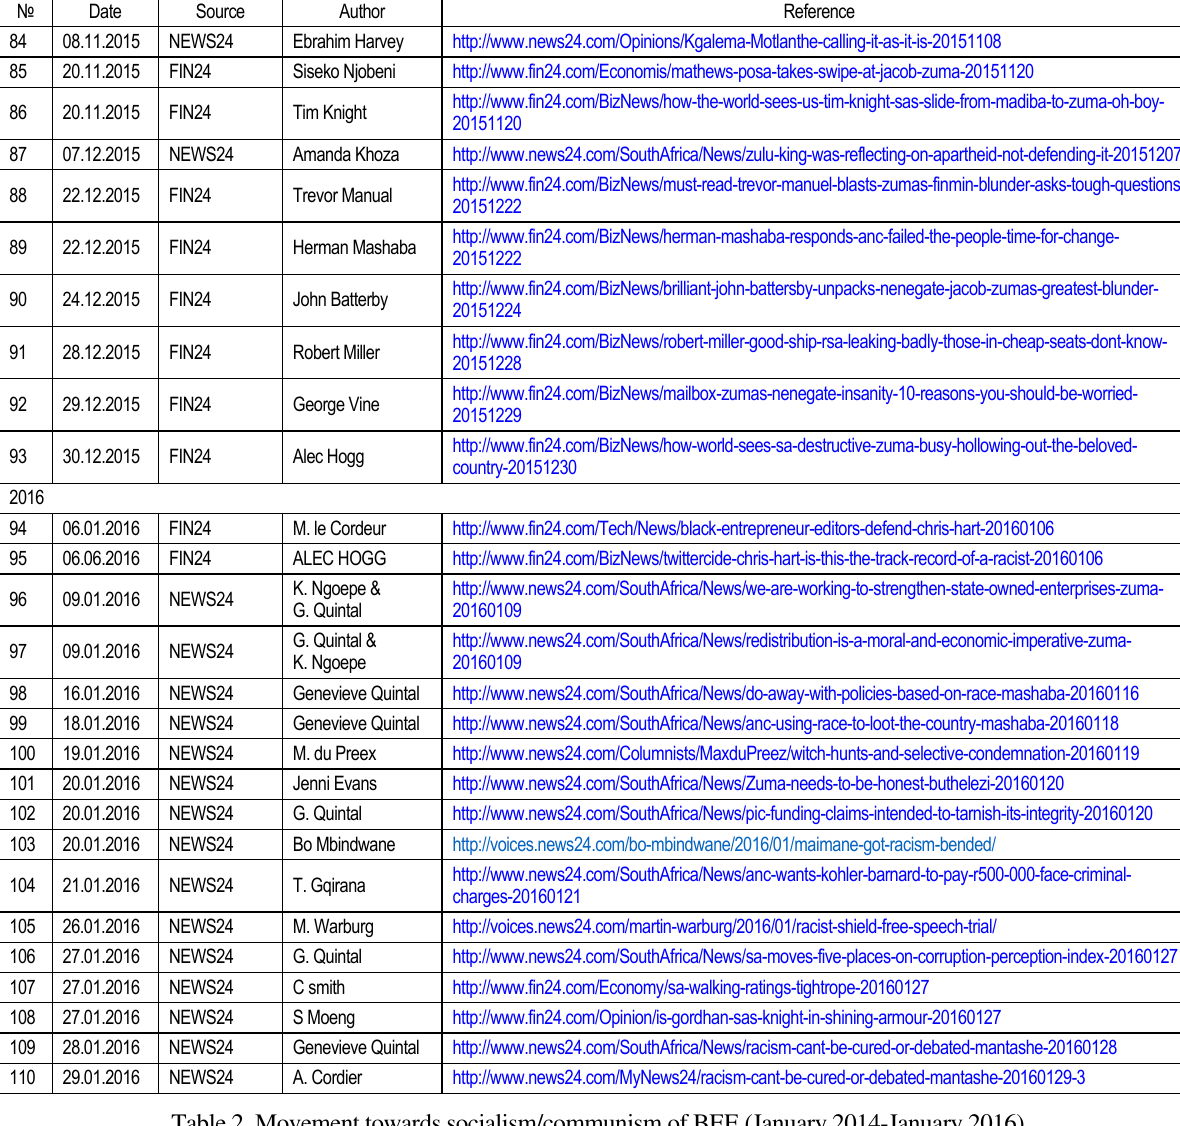
Table 2. Movement towards socialism/communism of BEE (January 2014-January 2016) Title